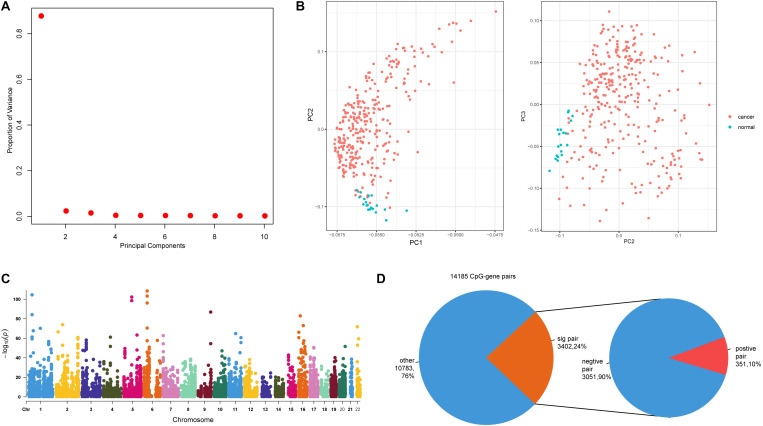
Relationships between promoter CpG sites and host genes. (A) The proportion of variance of the first three principal components (PCs). (B) Scatter plot of PC1 and PC2, and PC2 and PC3. (C) Manhattan plot of genome-wide p-values of CpG–gene pairs; dashed line indicates p = 0.01. (D) The first pie plot shows the proportions of significant and non-significant CpG–gene pairs. The second pie plot shows the positive and negative pairs derived from the significant pairs.